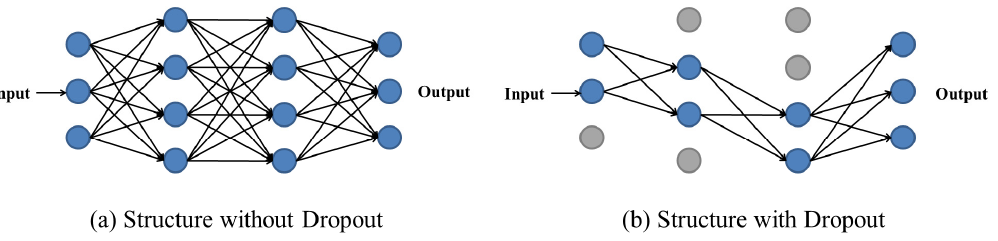
Figure 3. Illustration of the dropout method. (( a ) Structure with = out Dropout; ( b ) Structure with Dropout)